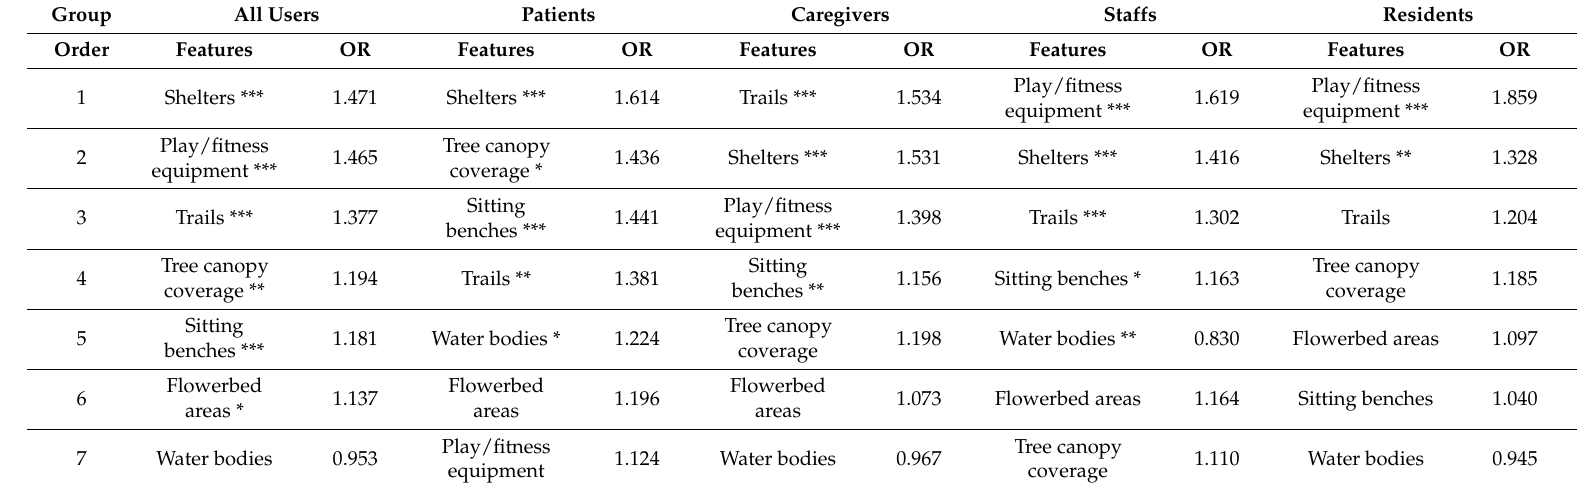
Table 6. The order and extent of the impact size of landscape features on user groups’ visitation